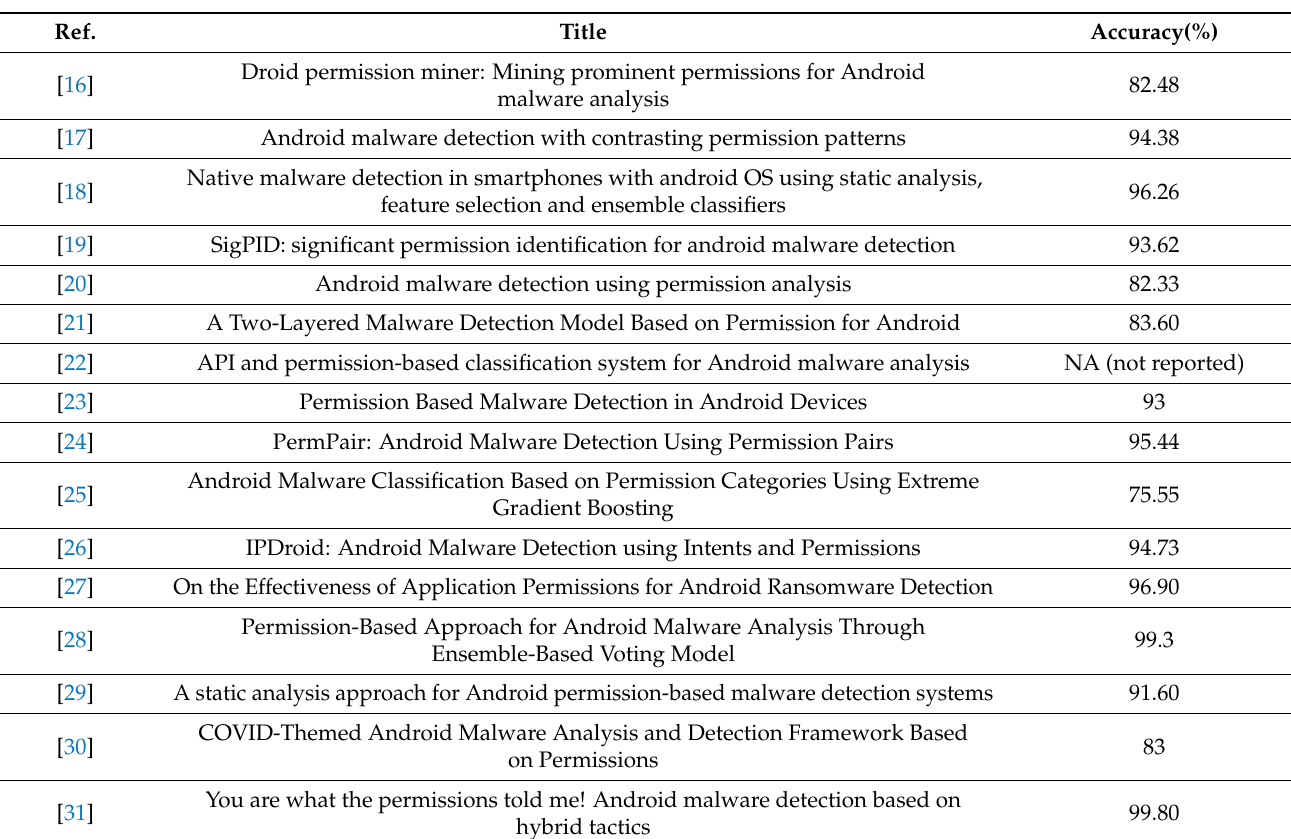
Table 3. Accuracy that was reported by each